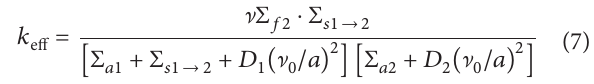
two. The off-diagonal values appear right next to the diagonal elements because of the chosen ordering of the